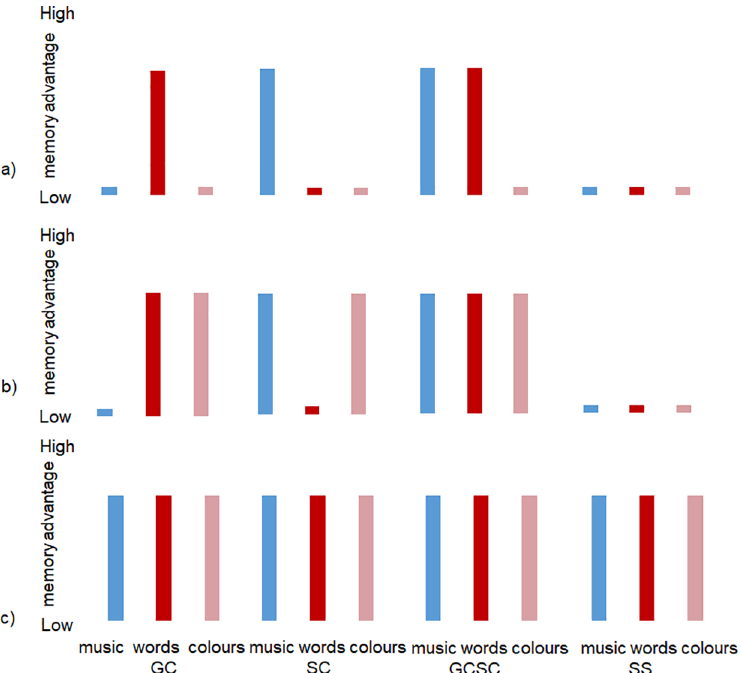
Fig 1. Expected results for the three possible mechanisms as mean differences between synaesthetic performance and performance of matched controls: a) an inducer-specific, b) a domain-specific and c) a general memory advantage of synaesthetes. GC = Grapheme-colour synaesthetes; SC = Sound-colour synaesthetes; GCSC = Grapheme-and-Sound- colour synaesthetes; SS = Sequence-Space synaesthetes.